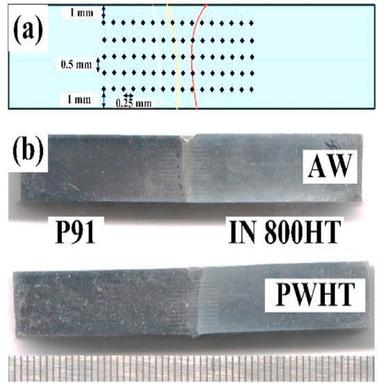
(a) Schematic representing the array design of microhardness indents taken on (b) AW state and PWHT state specimens.